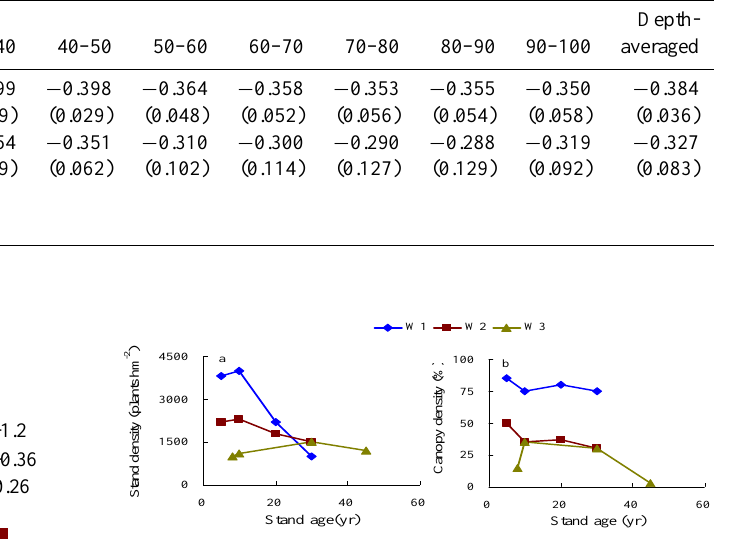
Fig. 4. Variations in stand density and canopy density with stand age in the different watersheds.